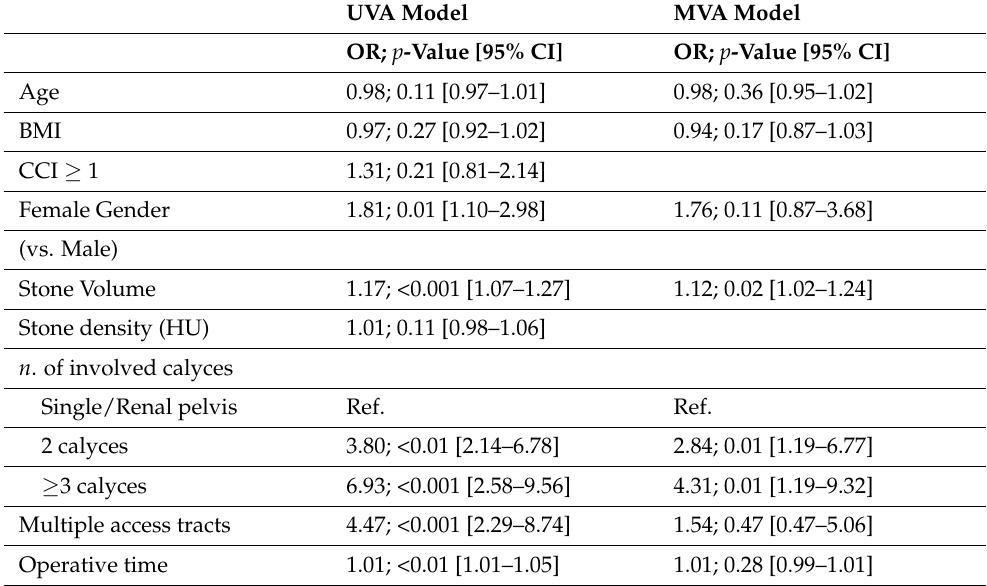
Table 3. Logistic regression models predicting unfavourable trifecta achievement ( −